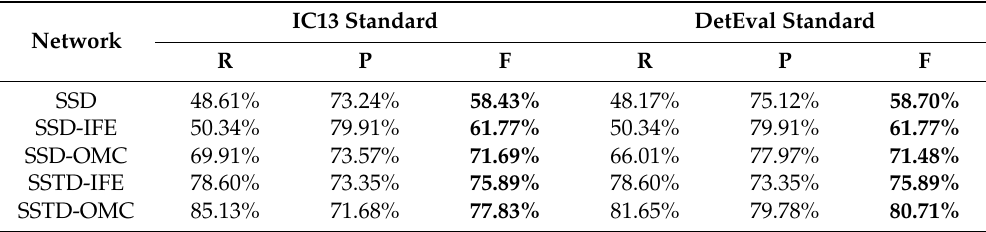
Table 2. Comparison of IFE and OMC algorithms (on